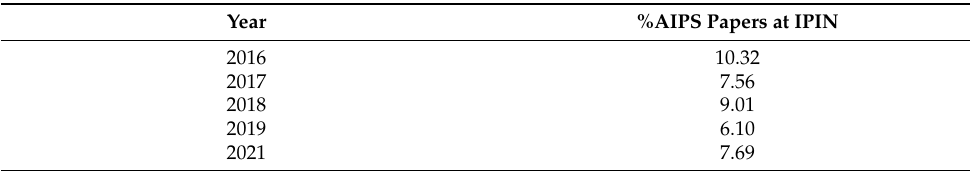
Table 1. Percentage of papers related to AIPS in the Indoor Positioning and Indoor Navigation Conference (IPIN).